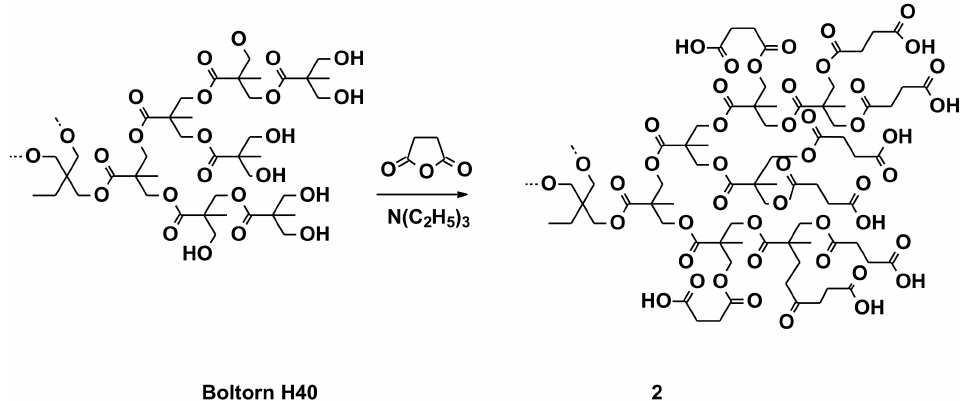
Scheme 2. Synthesis of Boltorn H40 with a carboxyl-terminal group In a typical procedure, 4.00 g (40 mmol) of succinic anhydride were dissolved in 75 mL of anhydrous THF in a 150 mL flask at 40 ◦ C under vigorous stirring. Succinic anhydride being completely dissolved, the mixture of a branched polymer (2.10 g Polyglycerol or 2.85 g Boltorn H40, 25 mmol hydroxyl groups) and 4.04 g (40 mmol) of triethylamine, dissolved in 50 mL of anhydrous DMSO, was slowly added into the flask and the final mixture was reacted for 4 h. The crude product formed was precipitated twice with cold diethyl ether and dialyzed against THF (Roth “ZelluTrans” membrane (Carl Roth GmbH + Co. KG, Karlsruhe, Germany), MWCO = 1000 Da) for 48 h.